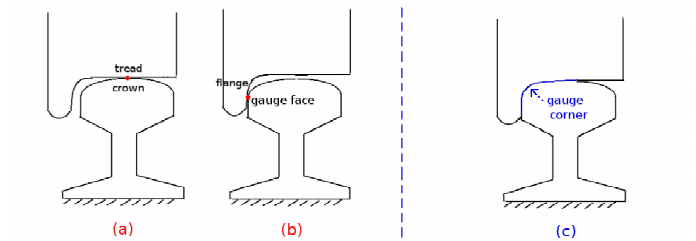
Figure 1. Two types of contact problems in wheel-rail contact [19]: concentrated contact in (a) and (b) with “flat contact areas”, and conformal contact in (c) with a “curved contact